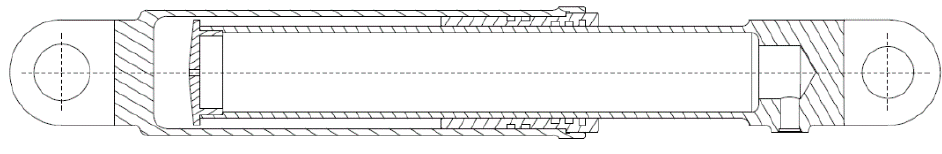
Figure 11. Internal structure of longitudinal buffer.